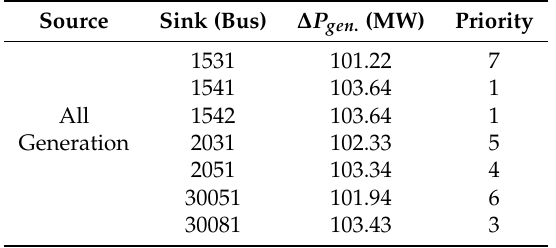
Table 3. Change in generation based on PTDF study and priority.